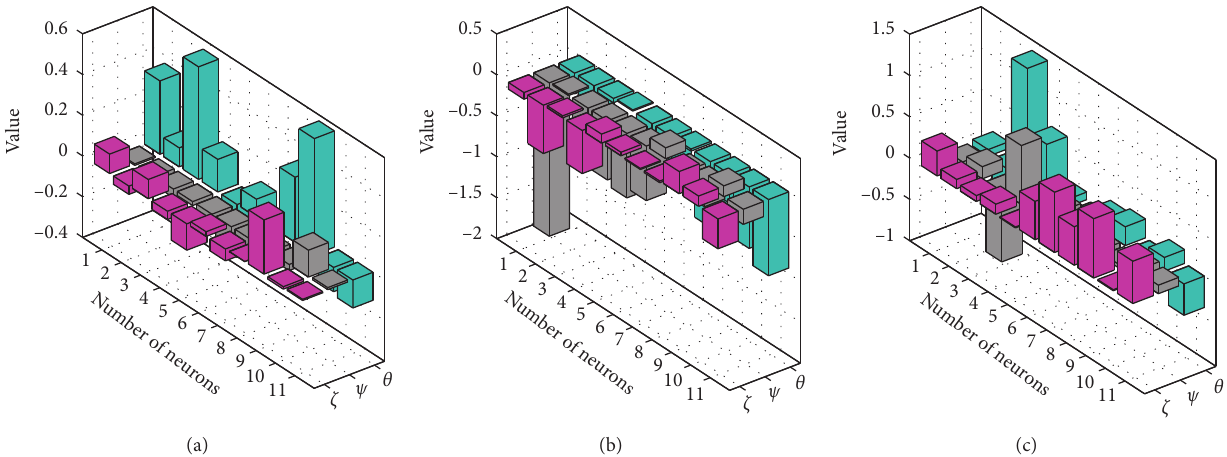
Figure 11: Trained neurons obtained by LeNN-NM algorithm for Problems 1–3. (a) Weights for Problem 1. (b) Weights for Problem 2. (c) Weights for Problem 3.